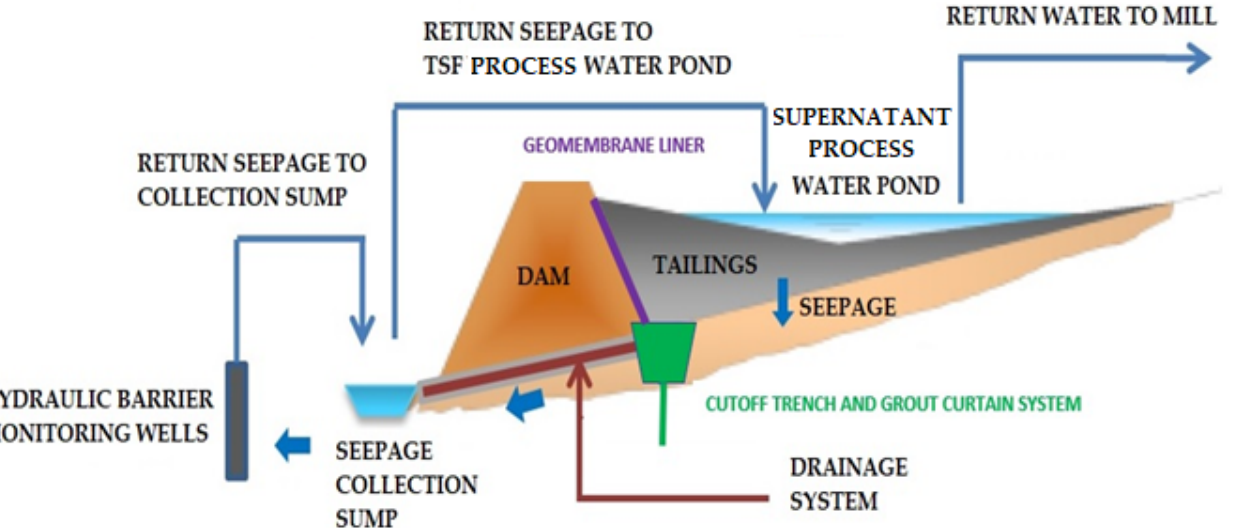
Figure 11. Schematic example of seepage collection system in TSF.